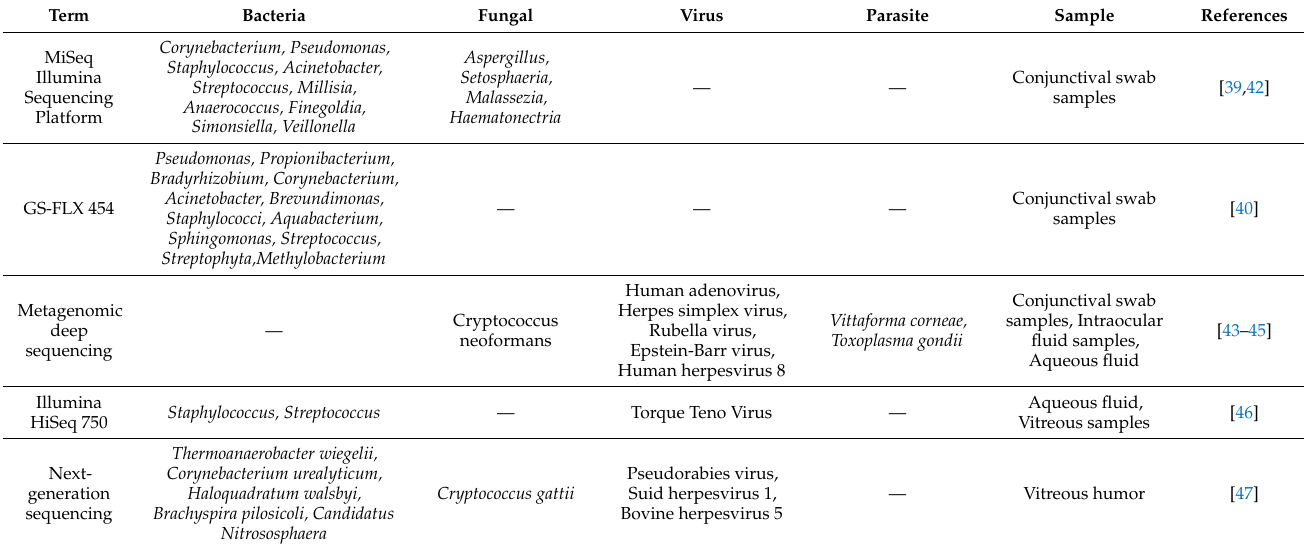
Table 1. Ocular microbes identified using high-throughput